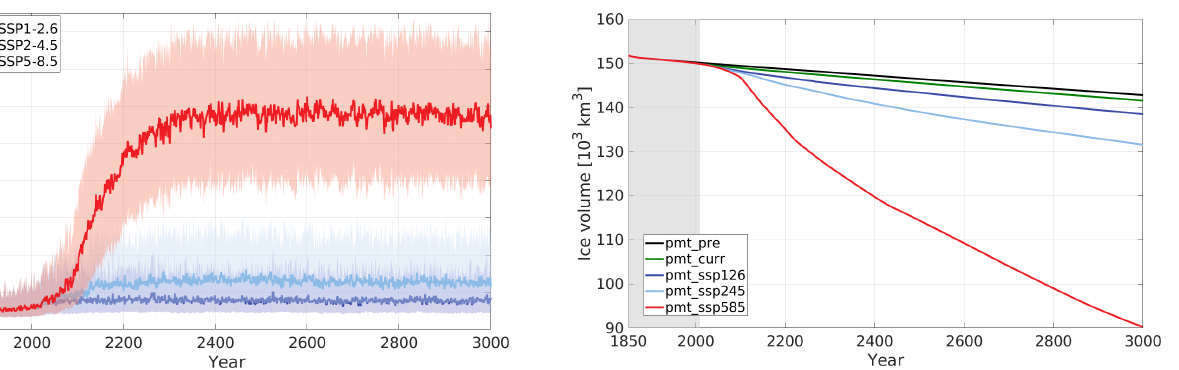
Figure 2. Benthic temperature. Lines are yearly averages over the area containing SSPF ice in 1850. Shaded areas show decadal means of the extreme months for each year and are combined RGB- wise.